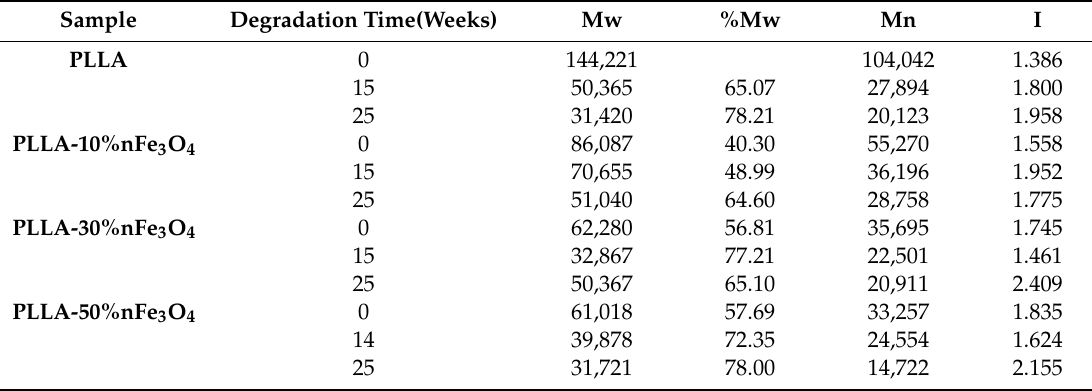
Table 2. Molecular weight: weight average (Mw), number average (Mn), and polydispersity index I of the PLLA- nFe3O4 system.